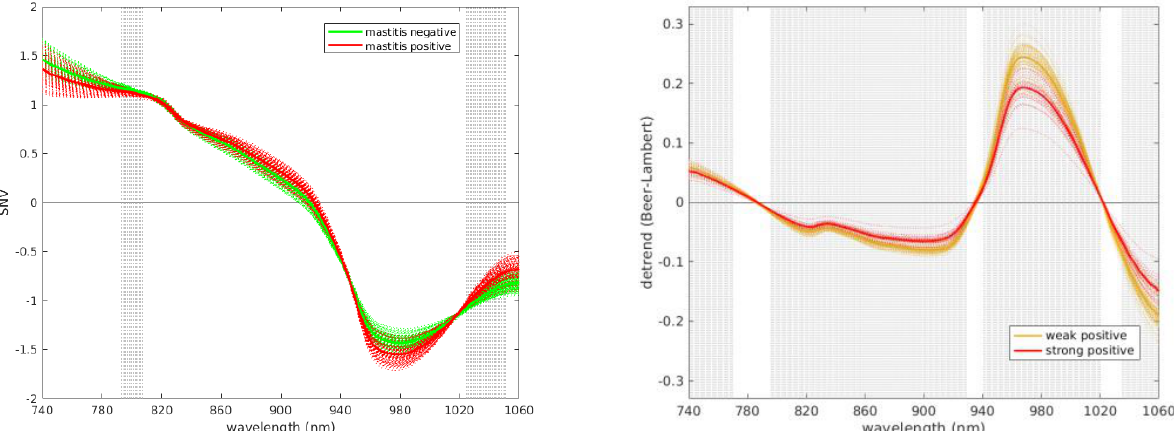
Figure 5. Processed spectra and relevant bands: SNV for model 1 ( left ), detrend and Beer–Lambert for model 2 ( right ).